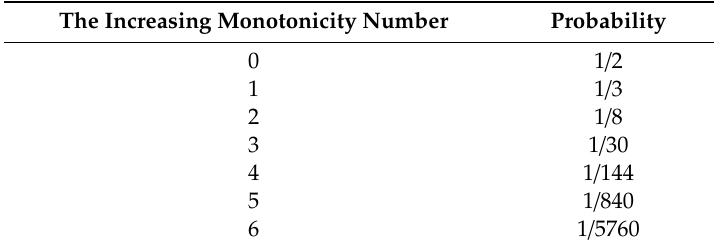
Table 1. First seven probabilities of the sample space of the increasing monotonicity number. The Increasing Monotonicity Number